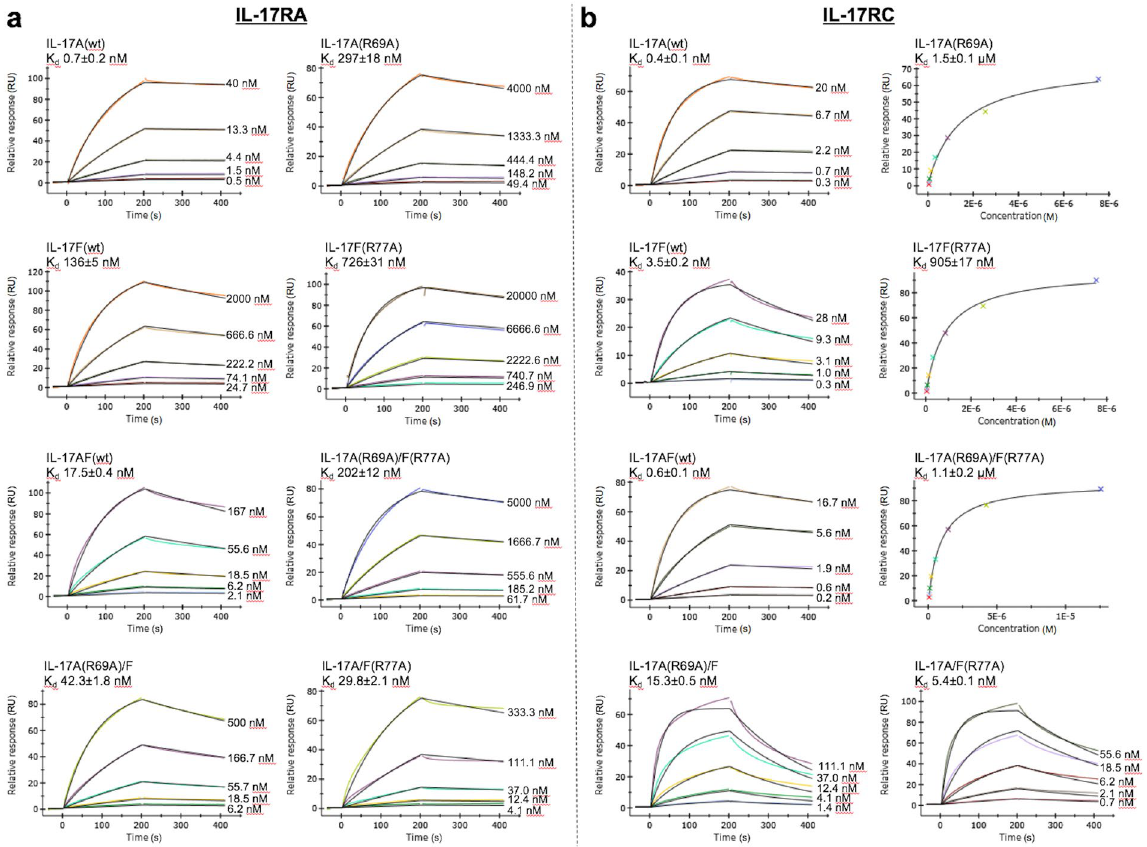
Figure 5. SPR affinity measurements of wild-type and variant IL-17A, IL-17F and IL-17A/F to the immobilized extracellular domain of the IL-17 receptors IL-17RA ( a ) or IL-17RC ( b ). Representative sensorgrams are plotted as response in resonance units (RUs) versus time and shown with colored lines. The concentrations of the injected analytes are indicated on the right of the sensorgrams. The kinetic parameters are calculated using a Langmuir 1:1 binding model with the fitted curves depicted as black lines. For cytokine variants with weaker affinity, the equilibrium dissociation constants were obtained from steady-state analysis by fitting the plot of the response at equilibrium (RUs) as a function of analyte concentration (M). The curve fit is shown as a black line. The indicated K d represents the mean from at least five independent experiments ± the standard error of the mean (sem) and are also summarized in Supplementary Table